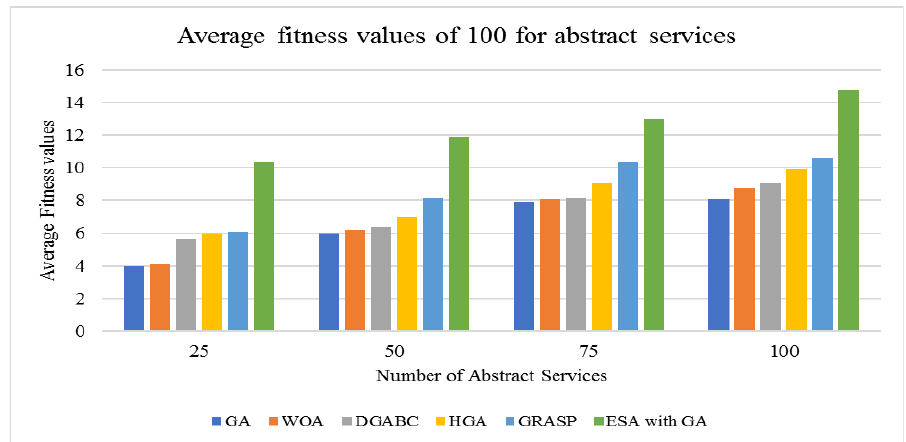
Figure 15. Best average fitness values for 100 abstract services.